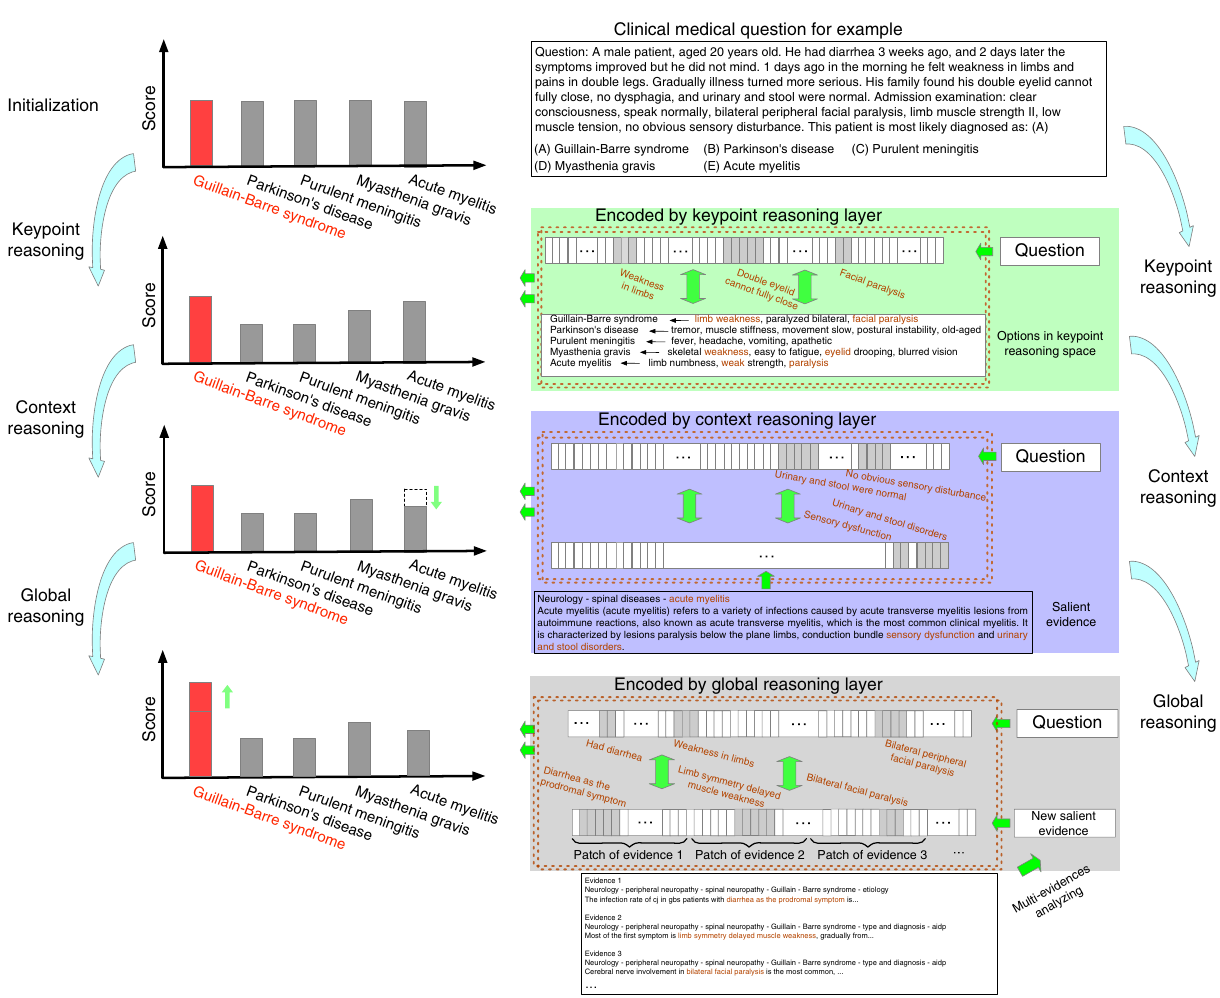
Fig. 7 Example of multi-layer reasoning process. Take a clinical medical question for example, key points of the question are extracted and encoded by the keypoint reasoning layer to determine candidate answers A, D, and E; in the context reasoning layer, a salient evidence is used to exclude the incorrect answer E at sentence level; and in the global reasoning phase, more related pieces of evidence are analyzed to form a new salient one to support the